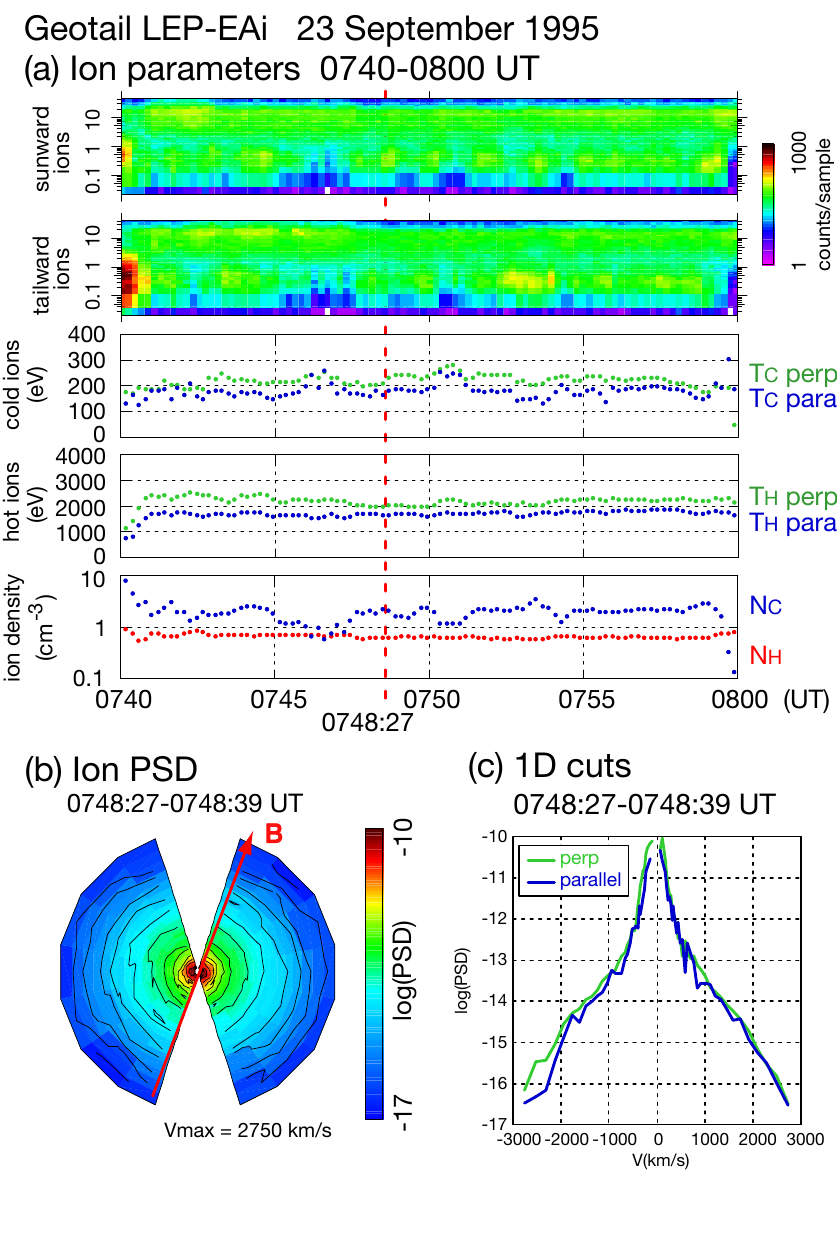
Fig. 4. The upper panel shows the Geotail observations between 07:40–08:00 UT on 23 September 1995, in the same format as Fig. 2. The lower panel shows a cut of ion phase space density for the 12-s interval 07:43:40–07:43:52 UT. plasma sheet near the low-latitude boundary, we surveyed the Geotail E-t diagrams by eyes for the period 1995–2000, and chose 15 intervals of two-component protons (11 in the tail and 4 on the dayside, whose XY positions are shown in Fig. 6a), imposing a condition that there are two separate peaks in the E-t diagrams. The relatively small amount of events is due to limitation of acquisition of the 3-D data. The fitted parameters of each event are averaged over the intervals when the ion counts had two peaks and flows were stagnant